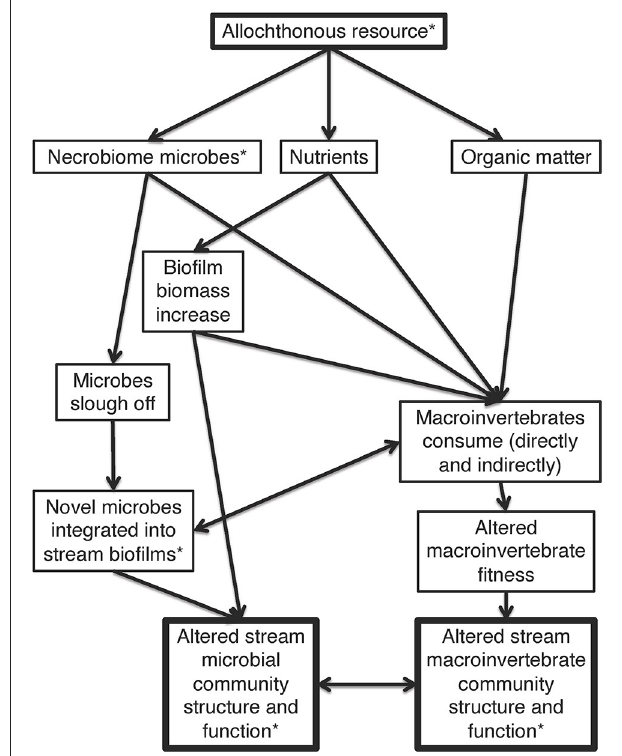
FIGURE 1 | Conceptual framework of allochthonous resources altering microbial and macroinvertebrate communities via nutrients, organic matter, and microbes. Arrows represent directional links of effects. An asterisk represents factors directly measured in this study, while those without asterisks are hypothesized. Hypotheses on the overall importance of each linked agent are not offered, as these may vary over time and space, and the overall figure represents how these components fit into the larger ecosystem